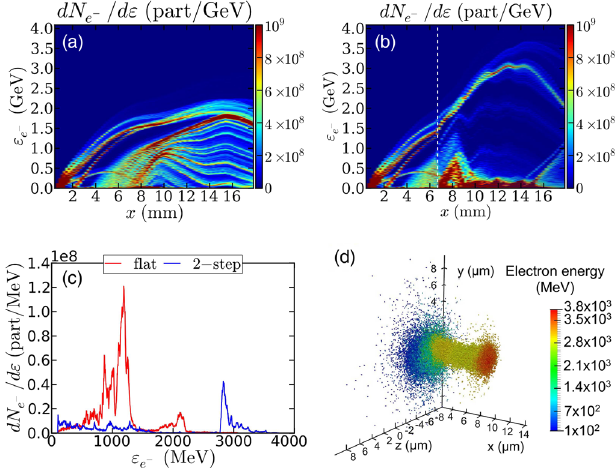
FIG. 3. Electron energy spectrum as a function of the longi- tudinal position in the plasma for the flat (a) and two-step (b) plasma density profiles. In (b), the dashed white line indicates the location of the density jump. (c) Energy spectra of the beam electrons for the flat (red) and two-step (blue) density profiles. (d) 3D space-energy distribution of the beam electrons for the two-step density profile. Each dot corresponds to a macroparticle, colored as a function of its energy in MeV (see color